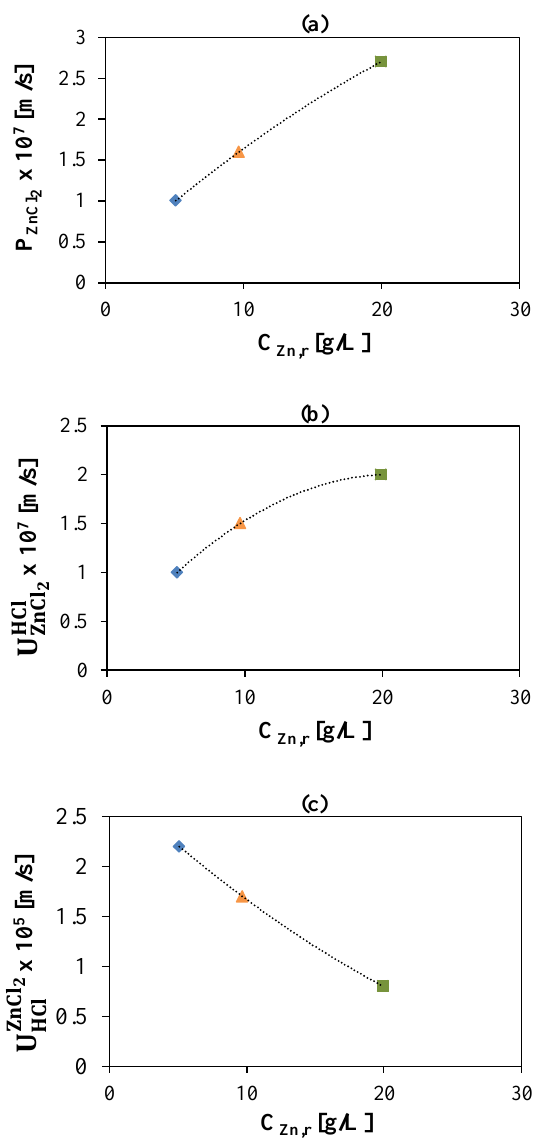
Figure 5. Model calibration results in terms of variation of the zinc diffusive permeability ( a ) , additional Zn mass coefficient ( b ) and additional HCl mass coefficient ( c ) as a function of Zn concentration in the feed compartment.